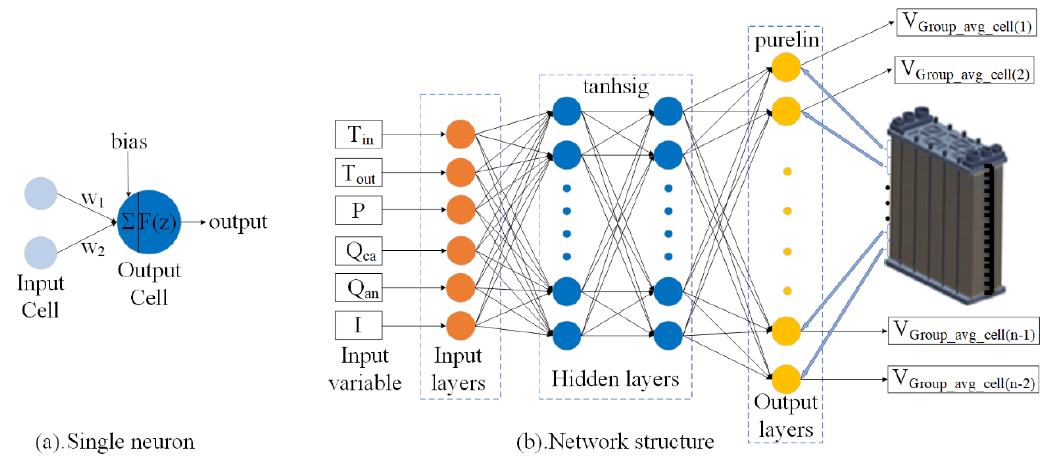
Figure 2. The ANN model structure for fuel cells: ( a ) the single neuron; ( b ) the multi-layer neural